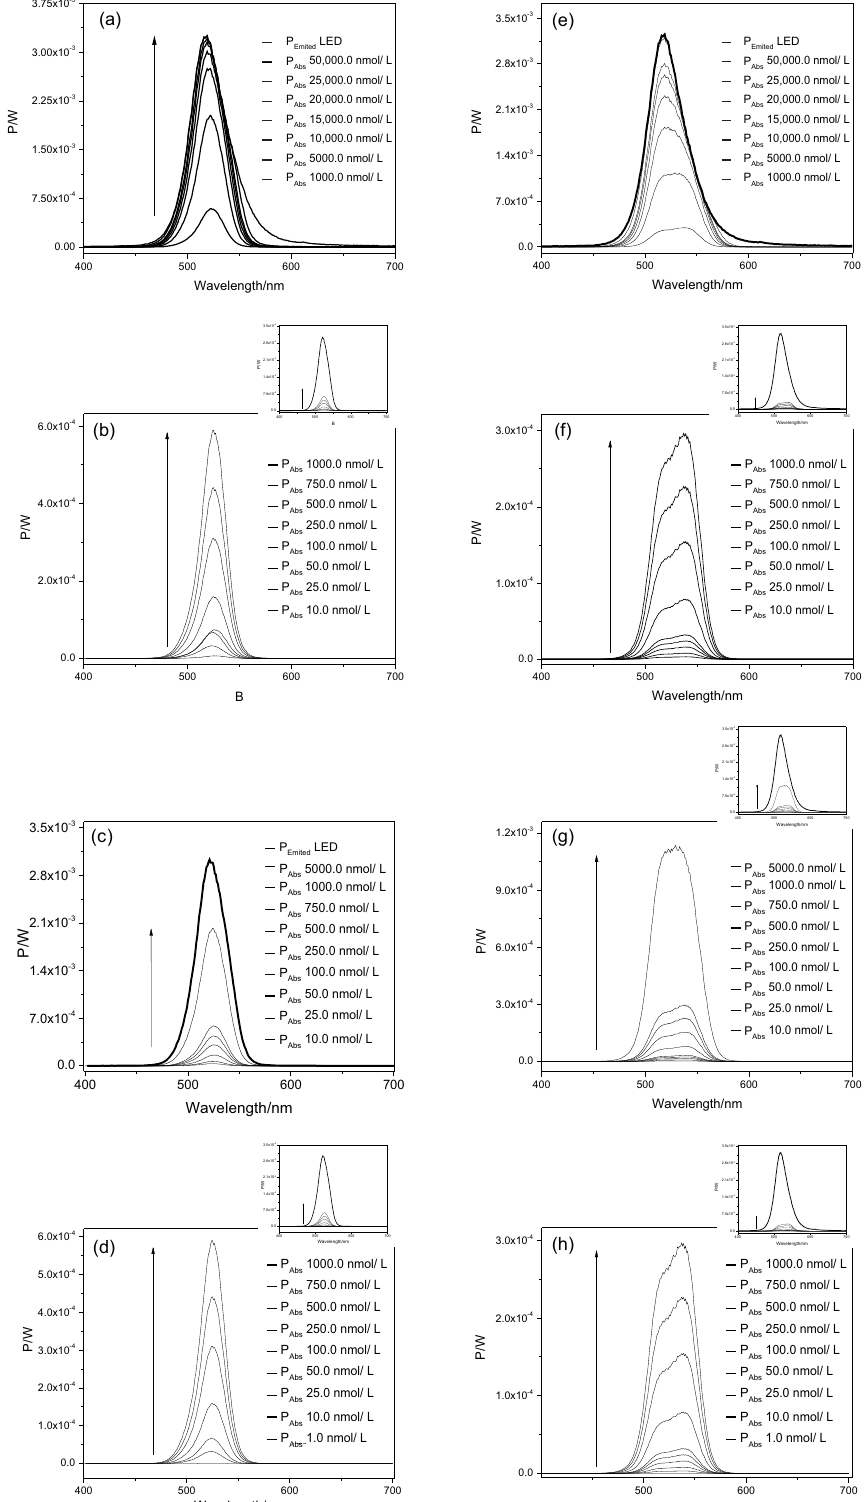
Figure 2. Spectra of light emitted by LED and power absorbed by ERY and RB for planktonic cells of E. coli ( a , e ), S. aureus ( b , f ), E. hirae ( c , g ) and L. innocua ( d , h ). The arrow indicates increase in photosensitizer concentration. The small chart displayed on the top-right side of figures ( b , d , f , g , h ) corresponds to its scaled-down